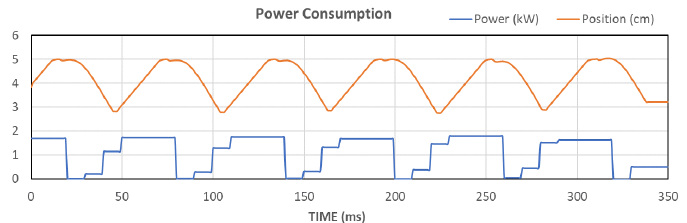
Figure 18. The power consumption of the electric hammer at the impact frequency of 18 Hz (Mayer